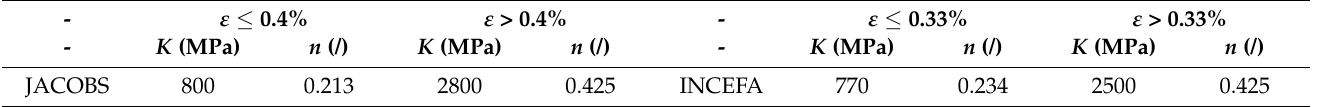
Table 3. Ramberg–Osgood parameters for JACOBS and INCEFA constitutive laws.